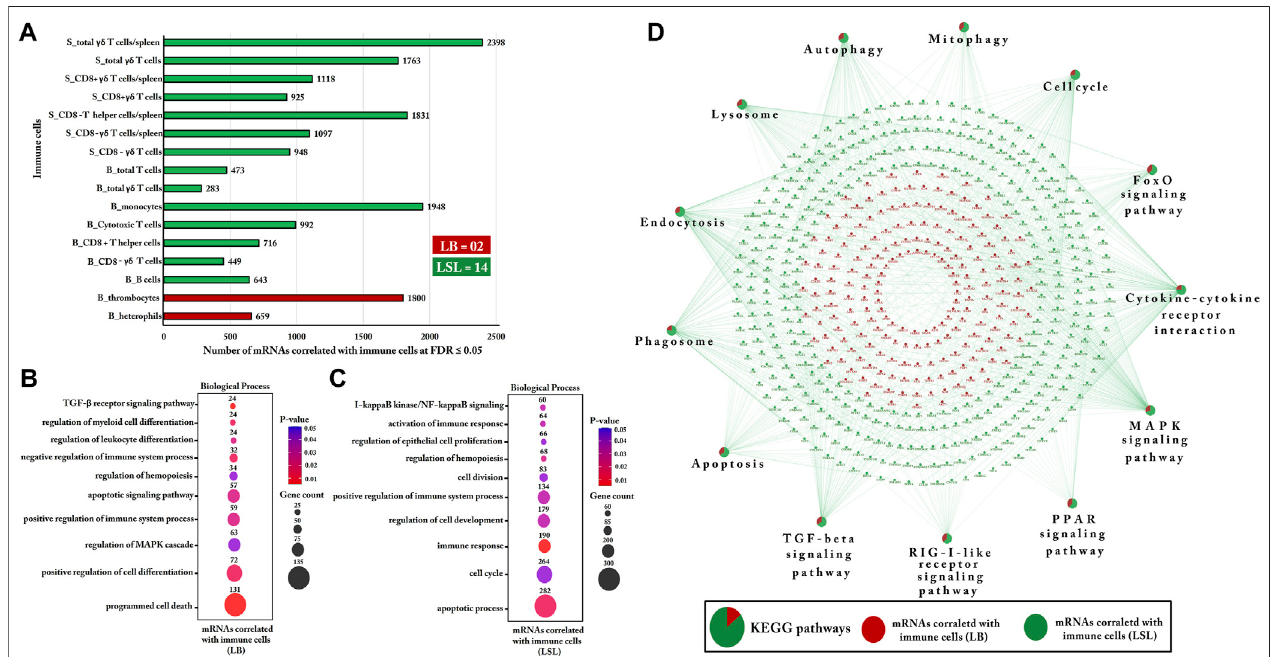
FIGURE 9 | Gene Ontology and KEGG pathways enrichment analysis of mRNAs correlated with immune cells within LB and LSL. (A) The bar chart indicates the number of mRNAs correlated with immune cells at FDR ≤ 5% within LB and LSL (|r ≥ 0.5|). The green bar shows the immune cells that are more abundant in LSL, while the red bar depicts immune cells that are more abundant in LB. (B) The transcripts correlated with immune cells in LB were subject to DAVID (version 6.8) for Gene Ontology (biological processes) enrichment analysis. (C) Gene Ontology (biological processes) enrichment analysis of transcripts correlated with immune cells in LSL. The dot size represents the number of transcripts involved in each biological process, while the dot ’ s color indicates the p -value. (D) KEGG pathway enrichment analysisof mRNAs correlated with immunecells within LB and LSL. The pie charts indicate the strain-speci fi c proportions ofmRNAscorrelated withimmunecells to the KEGG pathways. The red ellipse shows mRNAs correlated with immune cells in LB, and the green ellipse depicts mRNAs correlated with immune cells in LSL. KEGG pathways and biological processes with p ≤ 0.05 were considered signi fi